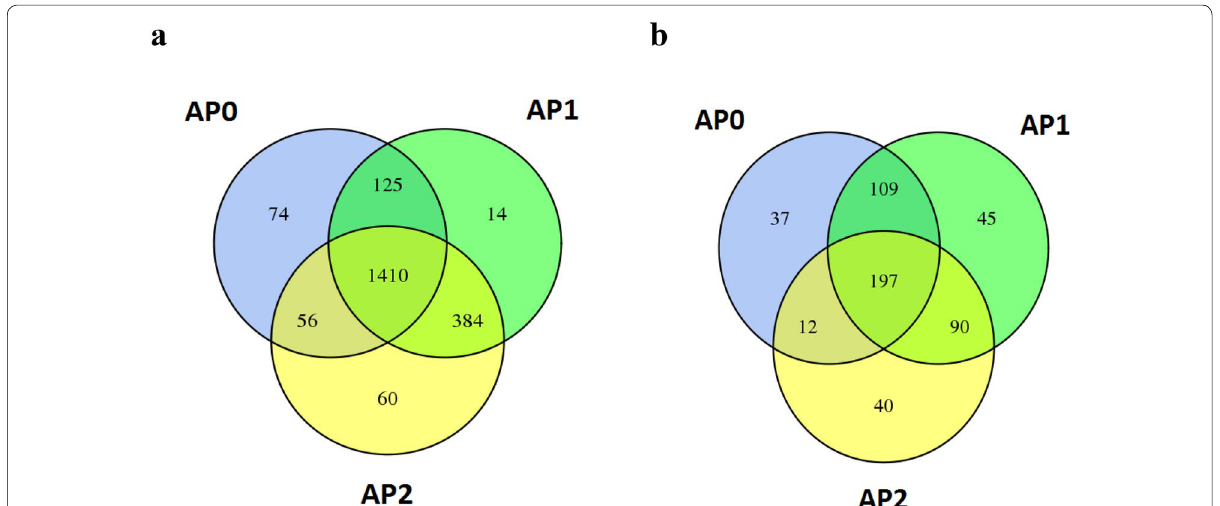
Fig. 1 Copy numbers of bacteria ( a ) and fungi ( b ). AP0, AP1 and AP2 represent soil with continuously cropping histories of Andrographis paniculata for 0, 1 and 2 years